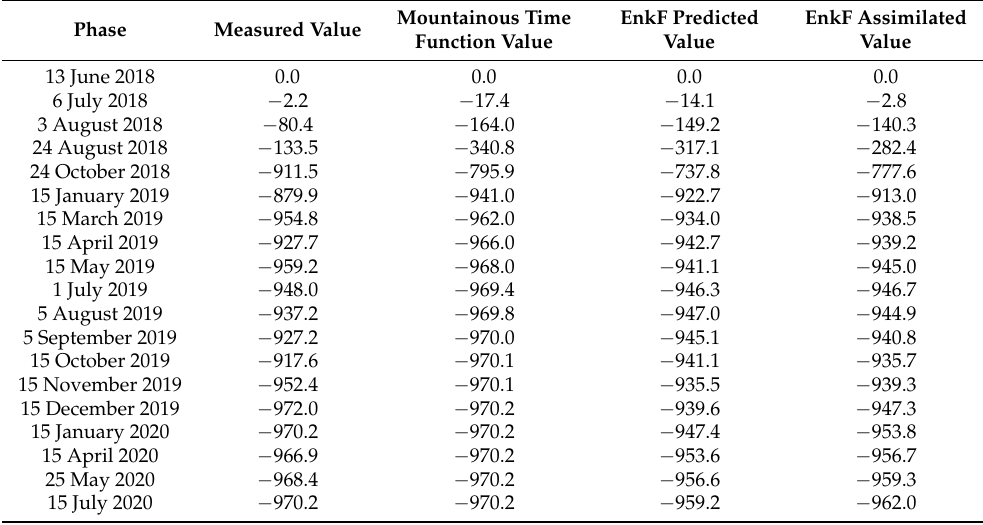
Table A2. The subsidence values of the observation point A24 acquired by different methods (mm).